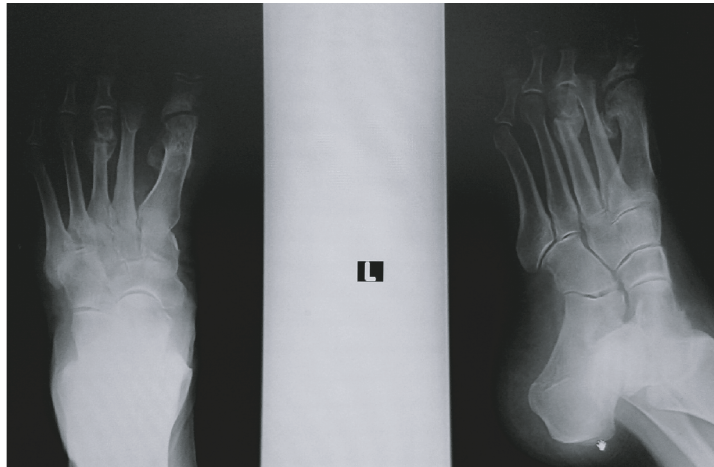
Figure 5: X-ray of the patient ’ s left foot three months after the operation.